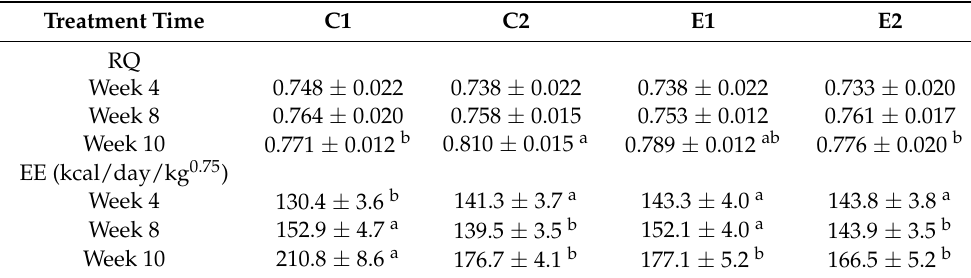
Table 2. Indirect calorimetry in the four experimental groups at different times.